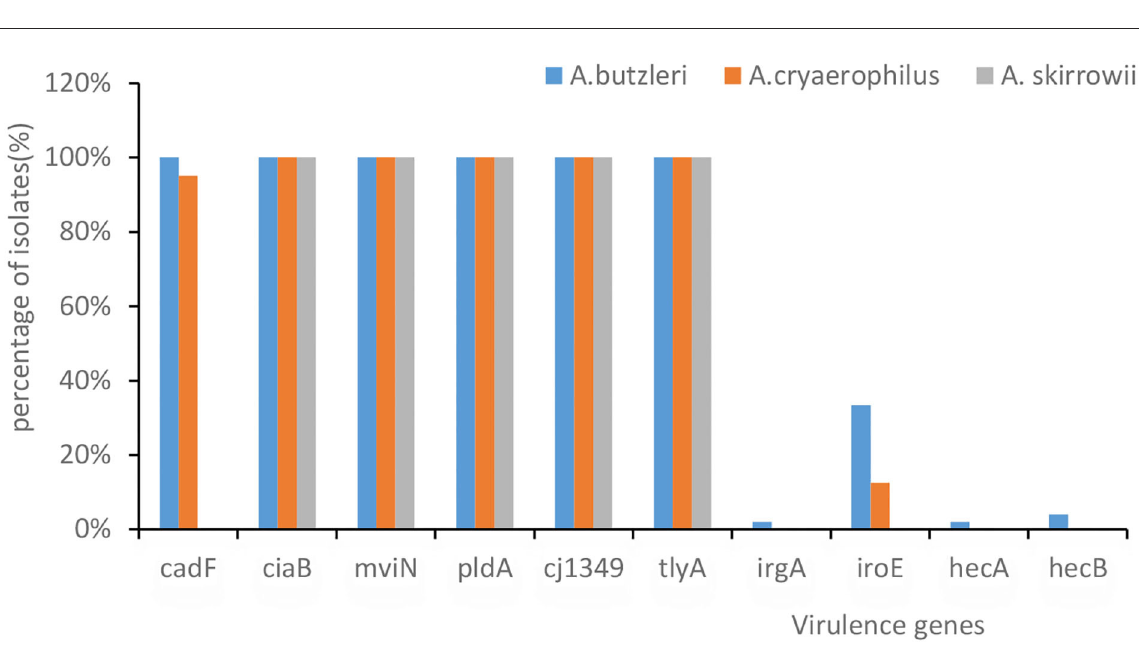
F132-4G) contained tetracycline resistance genes, tet (Y), tet (H), and tet (M). Strain F015-3G isolated from chicken contained one MDR gene island flanked by the insertion sequence IS4